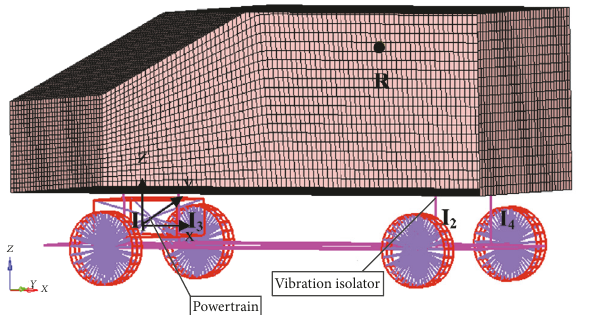
Figure 2: Simple vehicle model for conventional